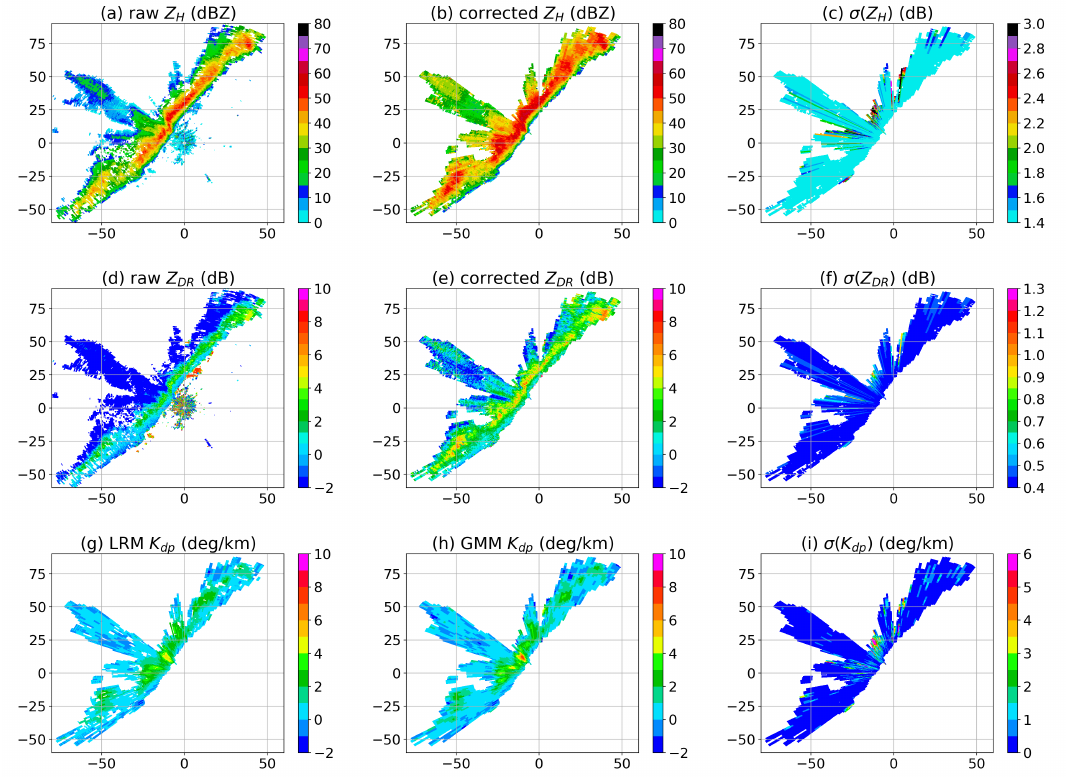
Figure 3. Plan position indicators (PPIs) of ( a ) raw Z H , ( b ) corrected Z H , ( c ) σ ( Z H ) , ( d ) raw Z DR , ( e ) corrected Z DR , ( f ) σ ( Z DR ) , ( g ) LRM K dp , ( h ) GMM K dp , and ( i ) σ ( K dp ) . The data were collected at 0411 UTC on 7 March 2017. The axes are in kilometers from the